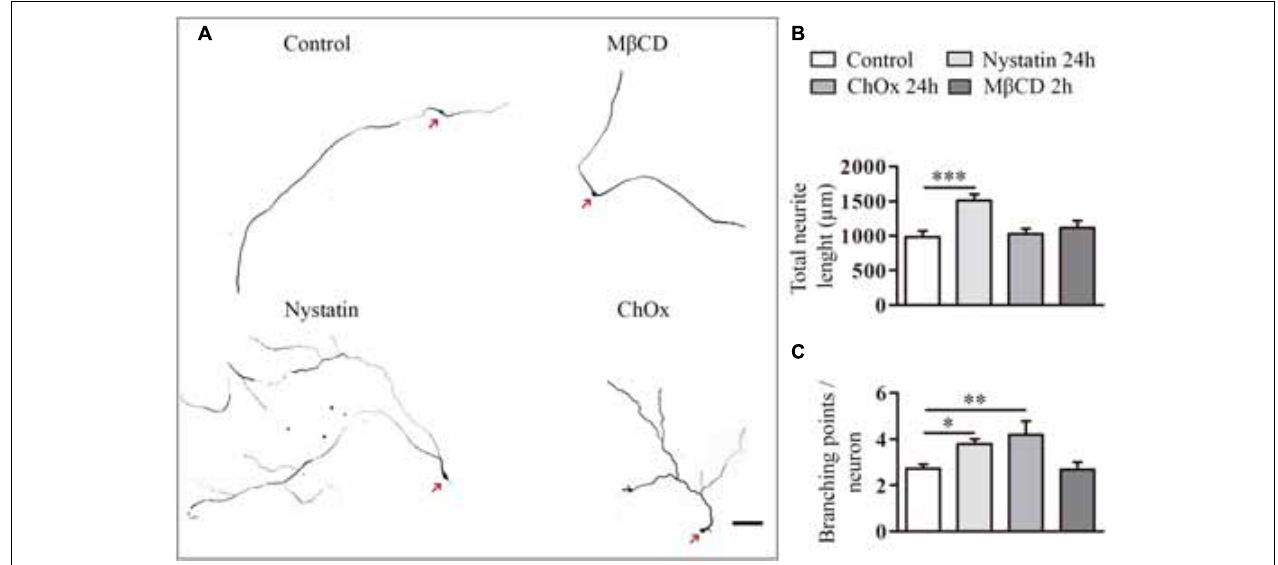
FIGURE 4 | Cholesterol depletion increases neurite elongation and branching in DRG neurons. Examples of DRG neurons incubated for long periods with control media, 2.5 µ g/ml Nystatin, 2U ChOx, and 0.5 mM M β CD (A) and immunolabeled with anti- β III-tubulin. Total neurite extension and number of branching points in each neuron were quantified in each condition in three independent experiments. Data represent means ± SEM (B,C) . N = 30–60 neurons in each condition (One-way ANOVA, Dunnett’s Multiple comparison test ∗ p < 0.05, ∗∗ p < 0.01, ∗∗∗ p < 0.0001). Arrows point cell body. Scale bar 100 µ